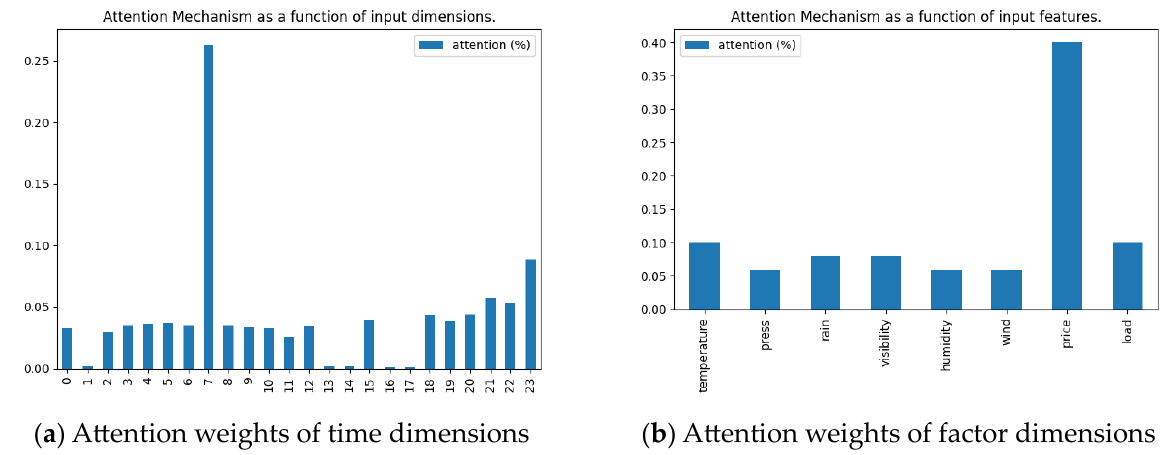
Figure 4. Time dimension and factor dimension effect on weights in the German dataset.